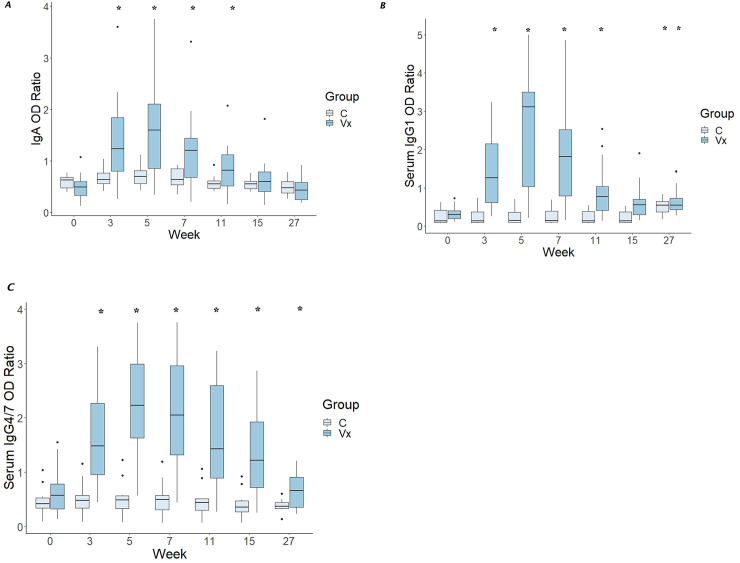
Vaccination significantly increased serum titers of IgA, IgG1, and IgG4/7.Optical density ratios from serum samples relative to a positive control of IgA (panel A), IgG1 (panel B), and IgG4/7 (panel C) antibodies among IM-only vaccinates (Group = Vx; n = 20) and controls (Group = C; n = 10). The bottoms and tops of the boxes represent the 25th and 75th percentiles, and the horizontal lines in the boxes represent the medians; the thin vertical lines extend to a multiple of 1.75 of the respective interquartile distance, and the small circles represent outliers. Asterisks indicate significant (P < 0.05) difference from baseline (Week 0) among vaccinates. For IgA (Panel A), concentrations were significantly higher than baseline through week 11 after initial vaccination (12 weeks after booster injection); for controls, there were no significant differences in titers at any of the time point comparisons. For IgG1 (Panel B), concentrations were significantly higher than week 0 from weeks 3 through 11, and again at week 27. For controls, values at week 27 were significantly (P < 0.05) higher than for all other times, but no other differences were significant. We attributed the higher titers at week 27 in both groups to be attributable to an artifact of testing or acquisition of natural antibody to PNAG. For IgG4/7 (Panel C), concentrations were significantly higher than week 0 from weeks 3 through 15; for controls, there were no significant differences among times.